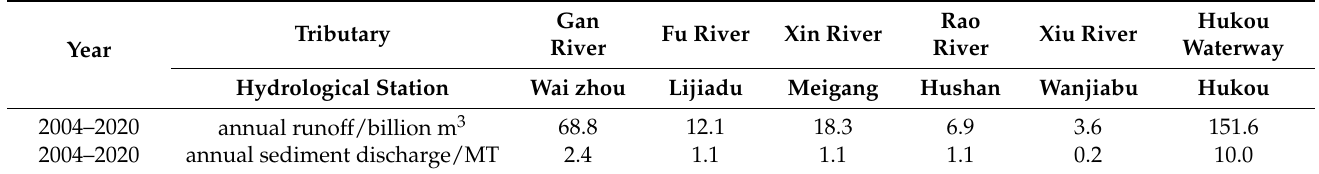
Table 4. Average runoff and sediment discharge in Poyang Lake.